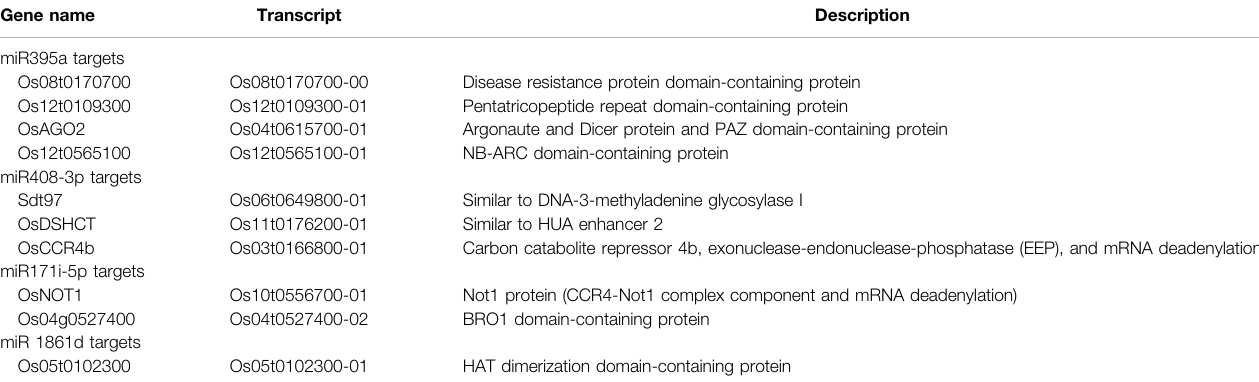
TABLE 2 | List of selected target protein-coding genes for the miR395a, miR408-3p, miR171i-5p, and miR 1861d. The target prediction analysis was performed by the psRNAtarget web server. A total of 10 targets were selected; among them 4 for miR395a, 3 for miR408-3p, 2 for miR171i-5p, and 1 for miR1861d were chosen.